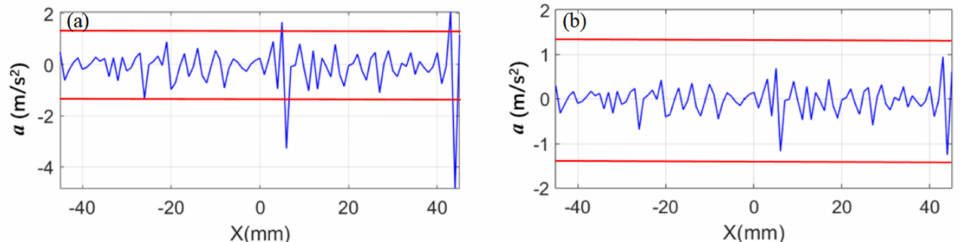
Figure 18. The dynamic performance requirements ( a ) before process parameter optimization, and ( b ) after process parameter optimization, where the red line represents the dynamic performance of the y -axis of